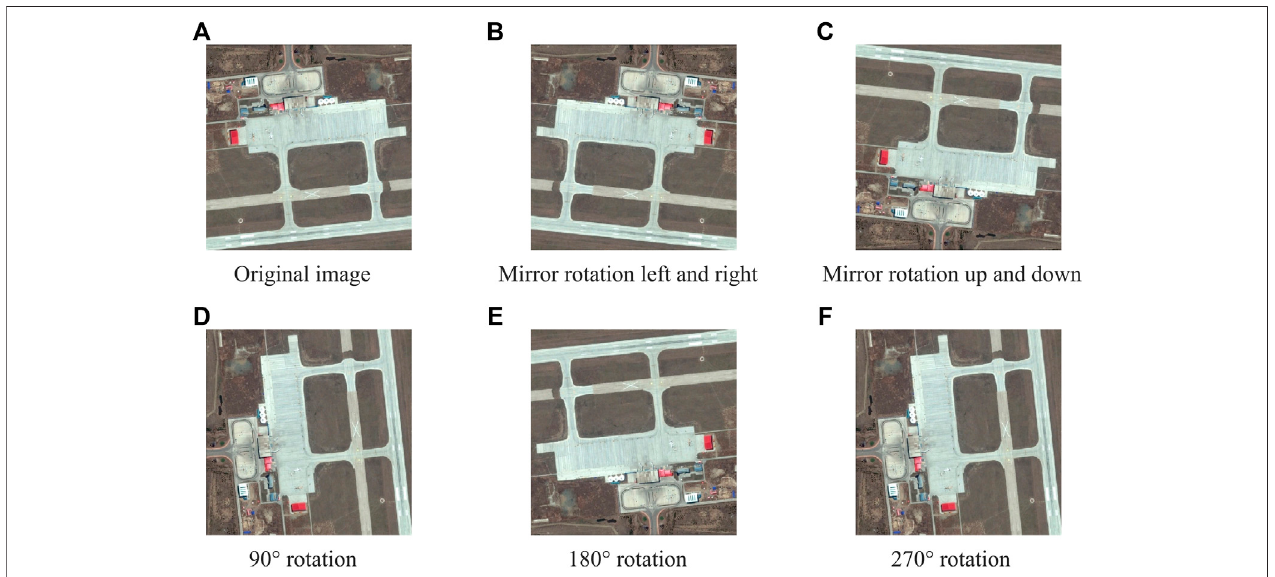
FIGURE 6 | Dataset enhancement example.